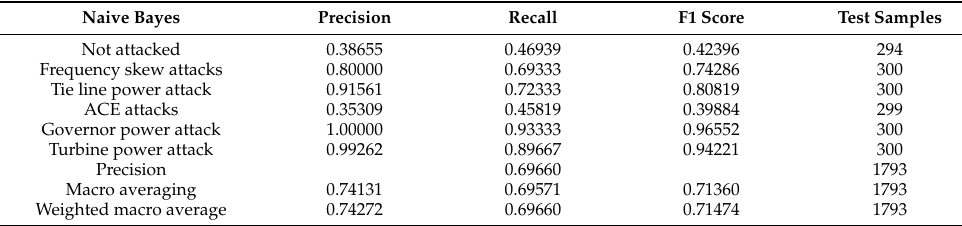
Table A7. The naive Bayes algorithm trained on model metric data. Naive Bayes Precision